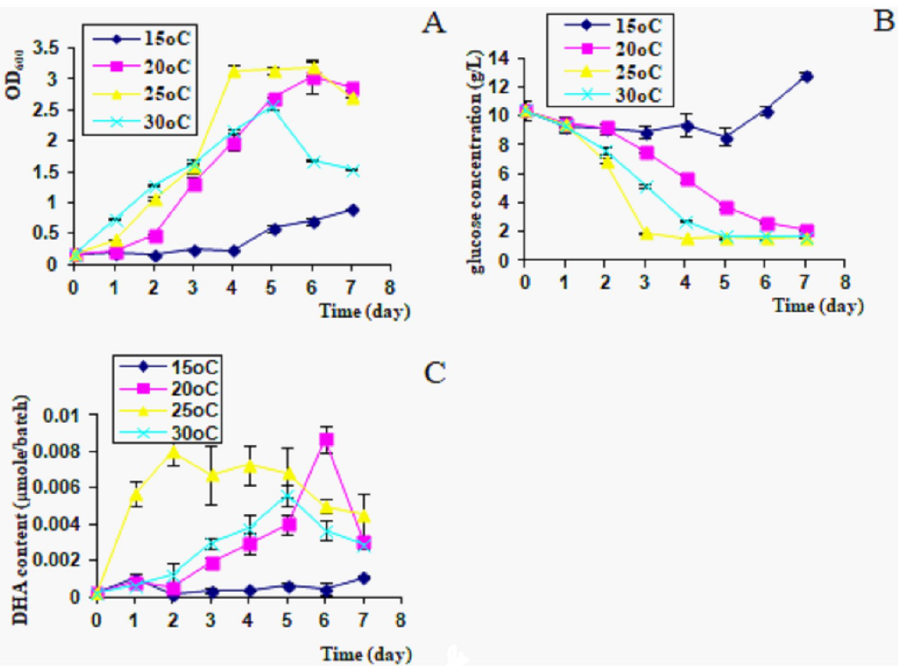
Fig 3. Growth rate and DHA production in different temperatures. A, OD 600 ; B, glucose consumption; C, DHA content in culture, 300 μ l/batch.